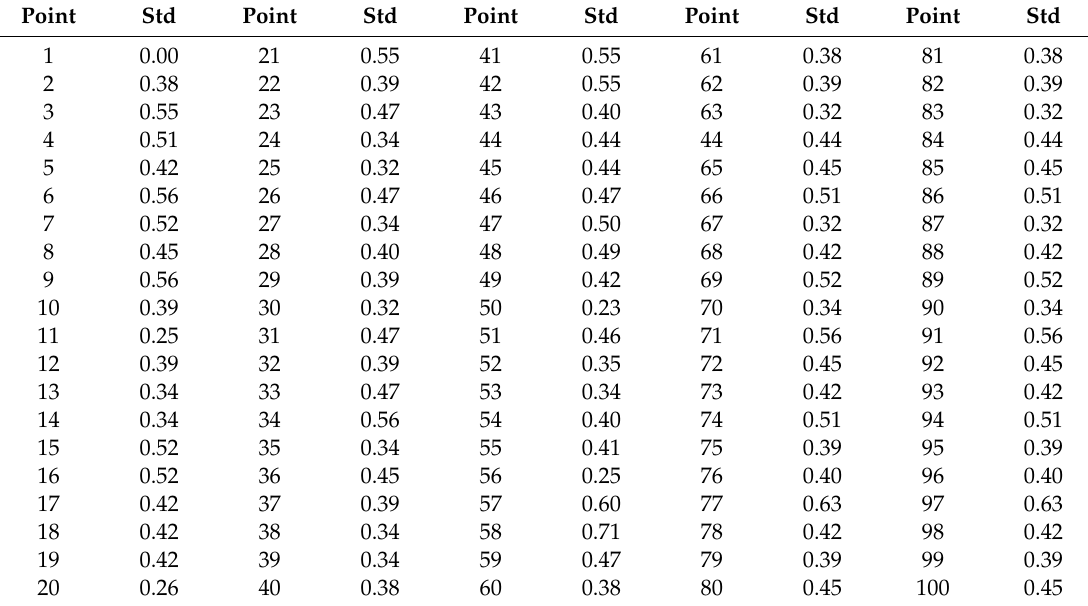
Figure 16. Test results for repeatability: ( a ) relative offset curve of the middle location; ( b ) distribution of standard deviation representing sample points. Table 1. Standard deviation (Std) of sample points.